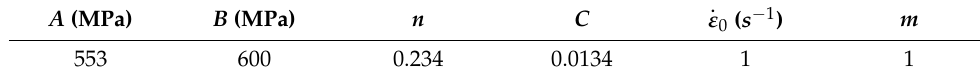
Table 1. J–C plasticity parameters of AISI 1045 [27].